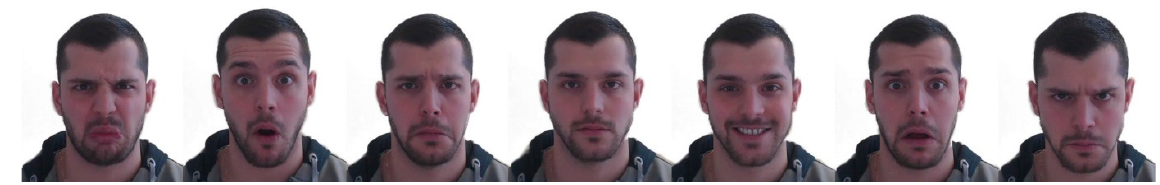
Figure 2. Target showing the emotion expressions in the Person-Perception Task.